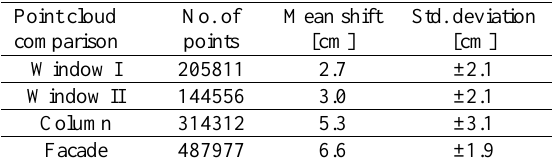
Table 5. C2C computations for the different parts of the